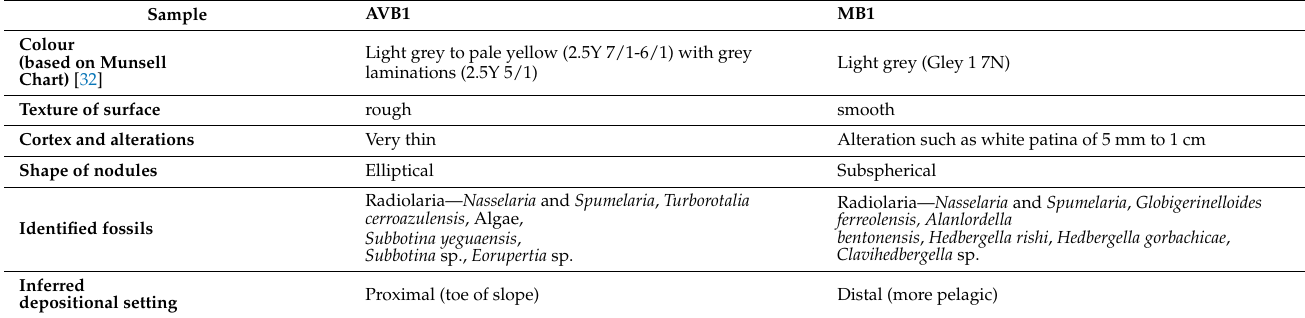
Table 1. Macroscopic features and micropaleontological data of the studied siliceous nodules.